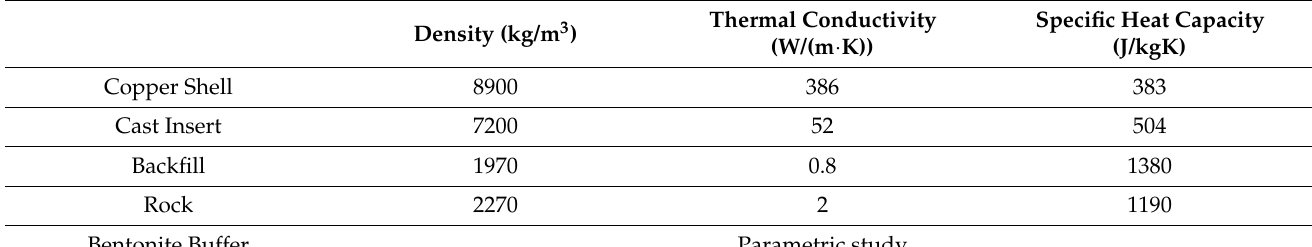
Table 1. Thermal properties for the numerical model.